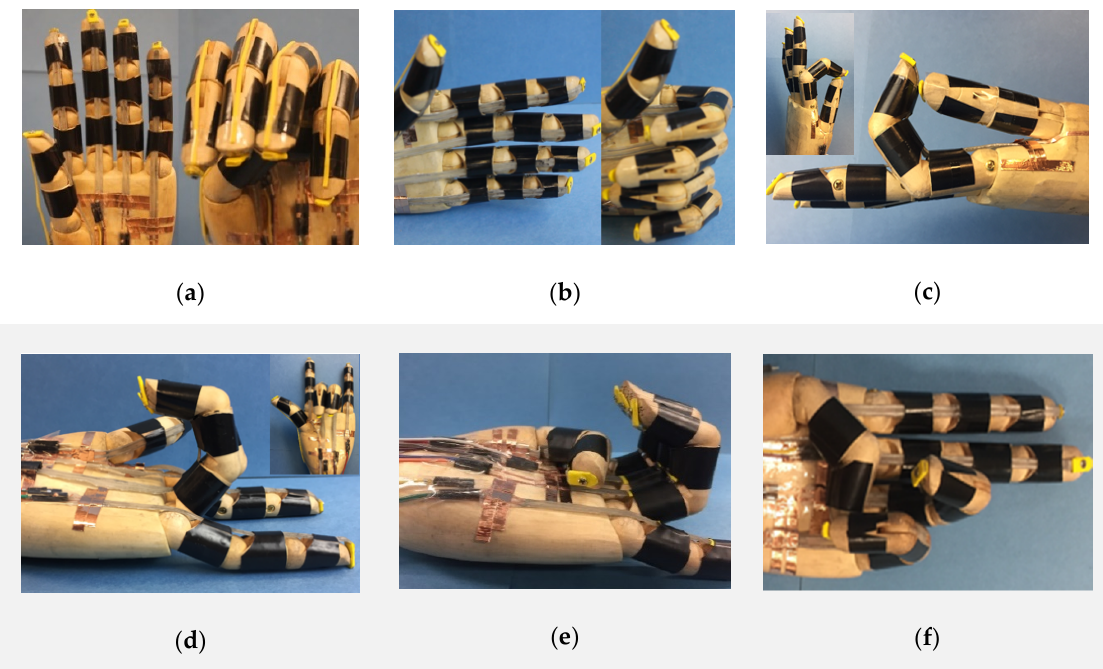
Figure 5. Hand gestures made by the biomimetic prosthetic hand. The biomimetic hand can coordinately control the fingers through the LCE tendons to realize various hand gestures, including ( a ) “fist”, ( b ) “thumb up”, ( c ) “OK”, ( d ) “I love you”, ( e ) “weak” and ( f ) “victory”.